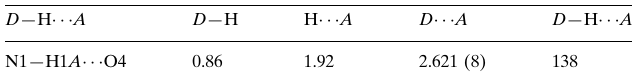
Hydrogen-bond geometry (A˚ , (cid:4)